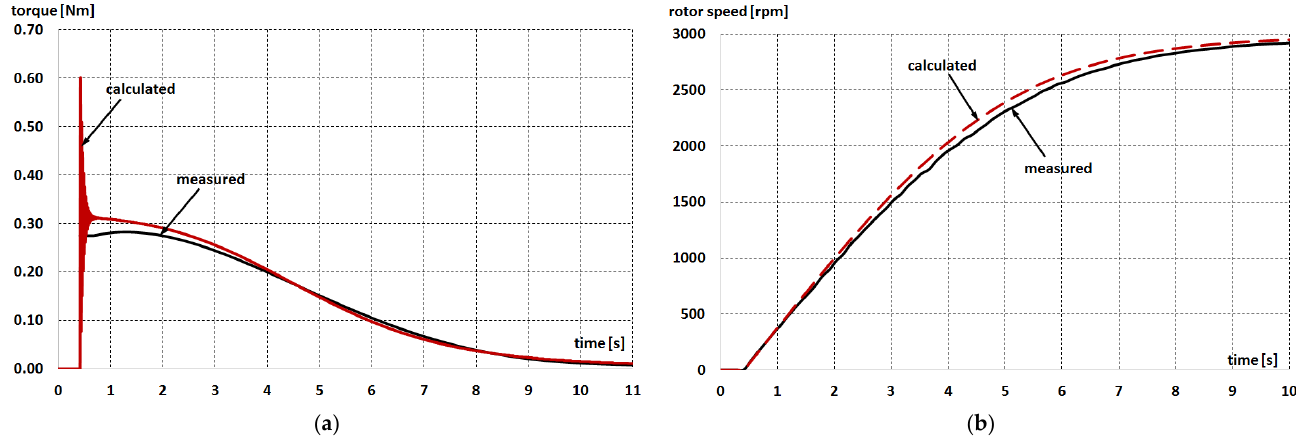
Figure 8. Measured and calculated time waveforms of the instantaneous value of the torque ( a ) and rotor speed ( b ) during direct motor starting when supplied from the mains with a voltage of 50 Hz, for the motor with additional inertia mass ( J = 0.00454 kg m 2 ).